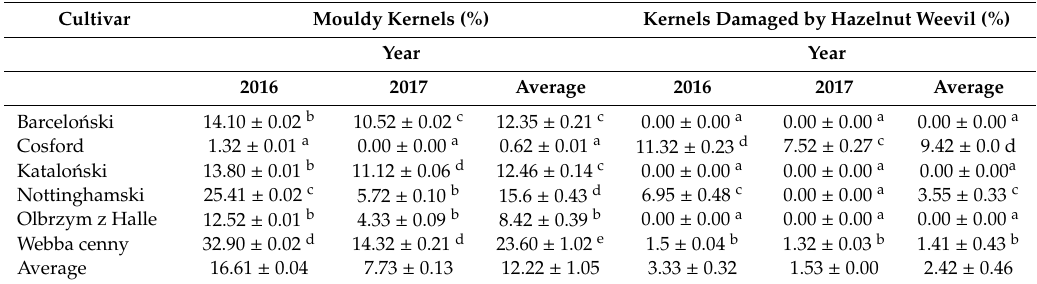
Table 1. Frequency of two types of kernel defects in 6 cultivars in 2016 and 2017 ( n = 90). Cultivar Mouldy Kernels